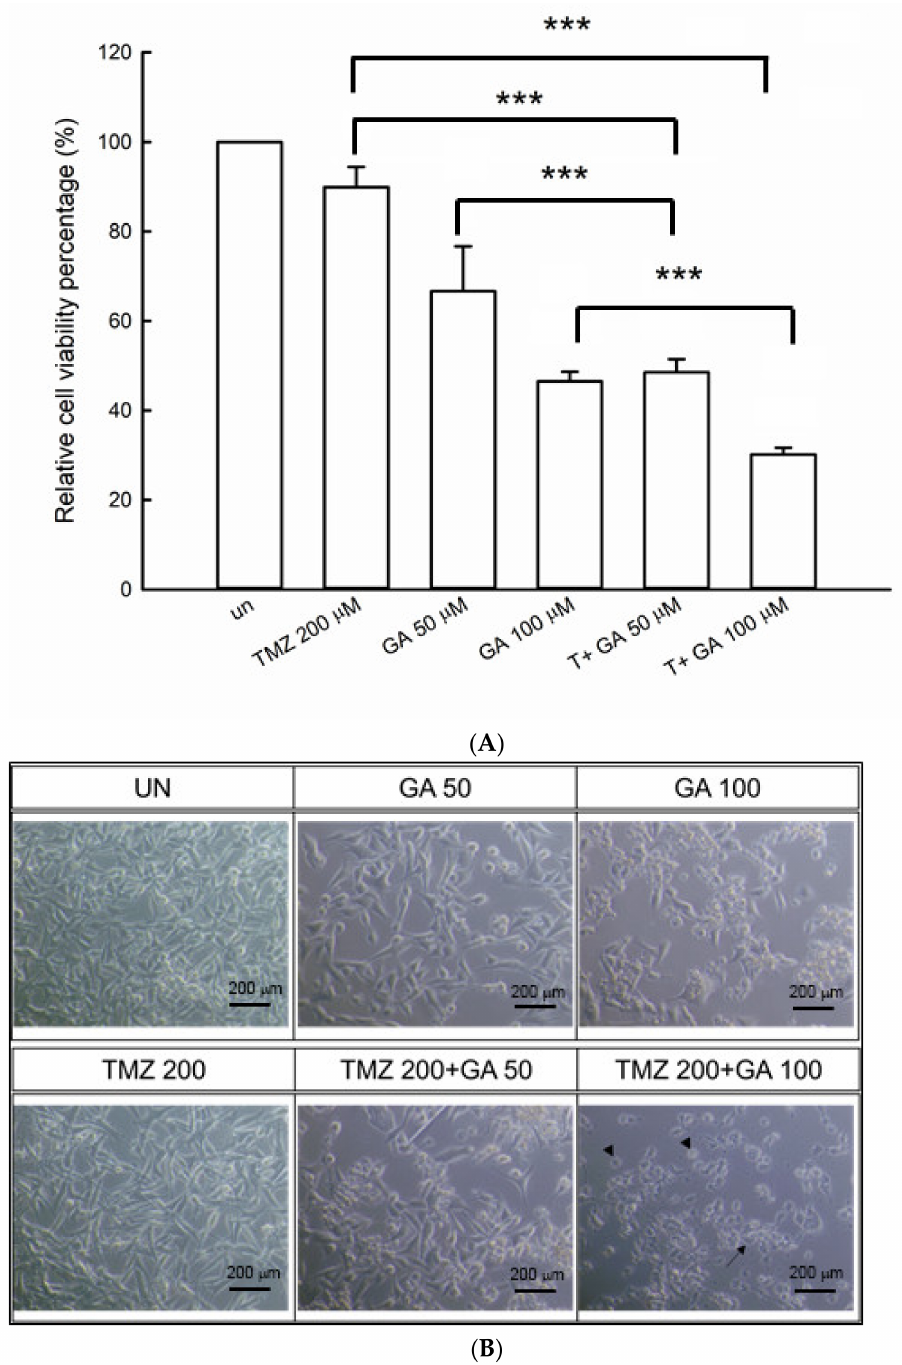
Figure 1. Assessment of ( A ) cell viability and ( B ) morphological findings on TMZ, Ga or Ga, and TMZ incubation. U87MG cells were plated in 96-well plates (1 × 10 4 /well) for 24 h and incubated with Ga (50 or 100 µ M), TMZ (200 µ M) or TMZ/Ga co-treatment for 48 h. The cell viability was detected using an XTT assay. (A) The data are shown as mean ± SD ( n = 5–8) of separate experiments. Significant difference is p < 0.001 (***). ( B ) The cellular morphology was examined by light microscope (scale bars are 200 µ m, magnification 200 × ). The long arrow indicates membrane blebbing. The arrow heads show apoptotic